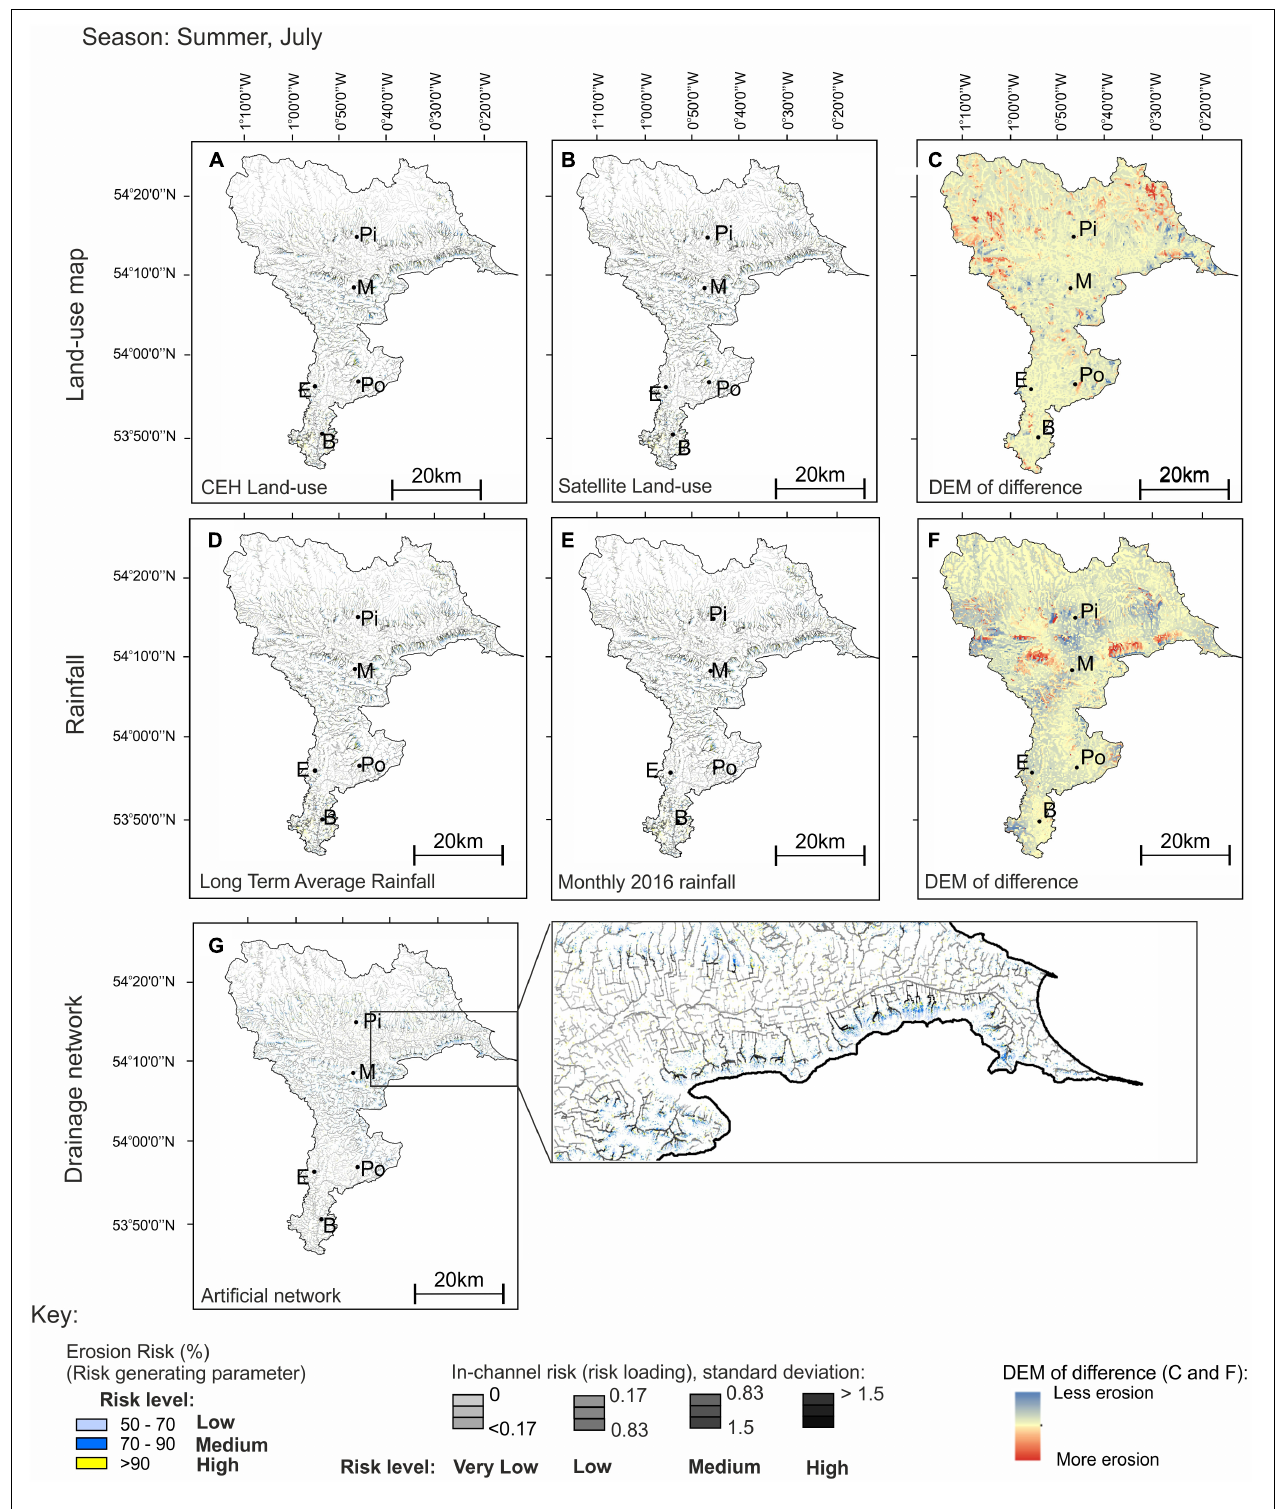
FIGURE 5 | Model scenario outputs for July, (A) CEH land use map; (B) satellite-derived land use map; (C) the DEM of difference between the two land use maps; (D) long term rainfall average; (E) monthly rainfall totals; (F) the DEM of difference between the two rainfall scenarios; and (G) the artificial drainage network. Locations are shown on each map; Pi, Pickering; M, Malton; Po, Pocklington; E, Elvington; B, Bubwith.